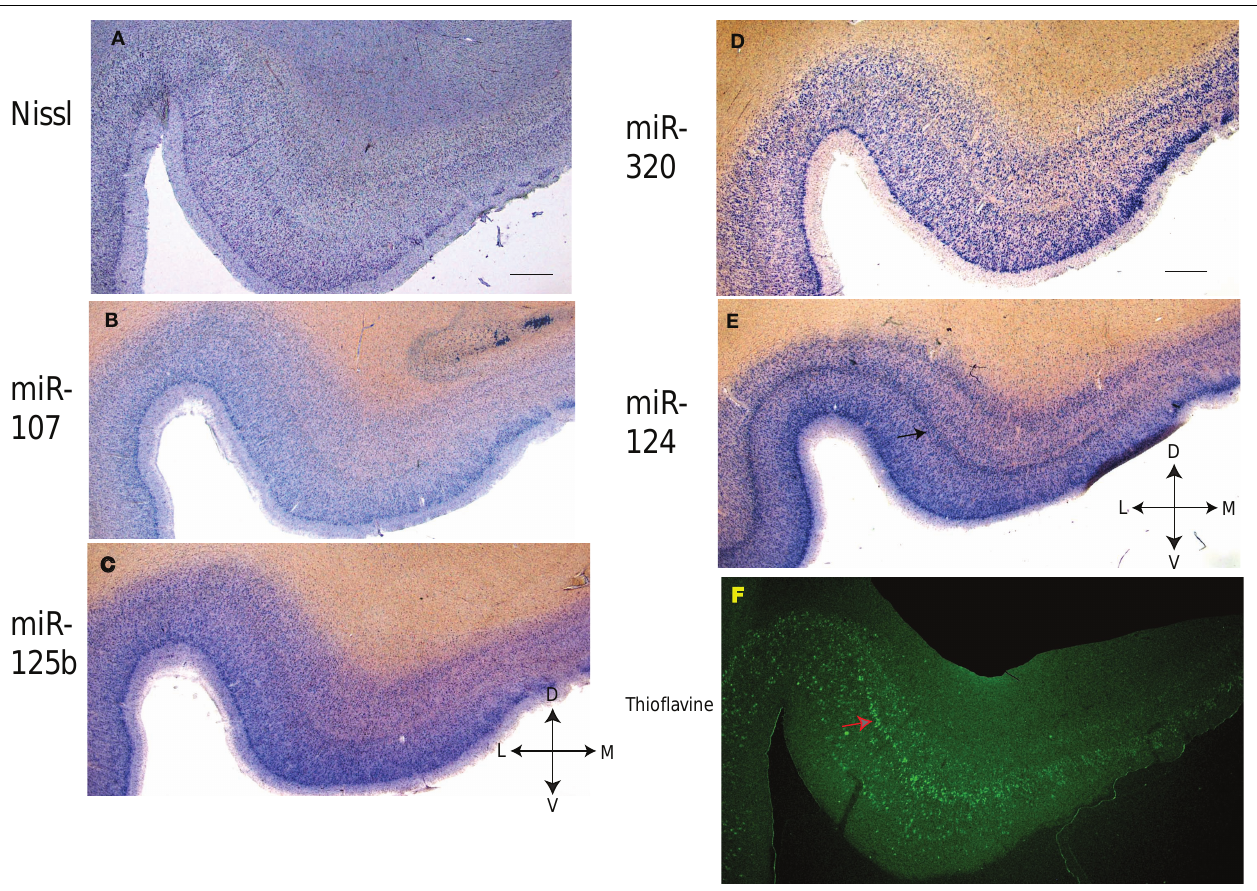
FIGURE 3 | In situ hybridization, Nissl, and Thiofl avine S stains for Case 3. (A) Nissl stain (B) miR-107 ISH (C) miR-125b ISH (D) miR-320 ISH (E) miR-124 ISH (band of stained cells indicated with black arrow), and (F) Thiofl avine S (amyloid plaques and neurofi brillary tangles are fl uorescent.). In this case there